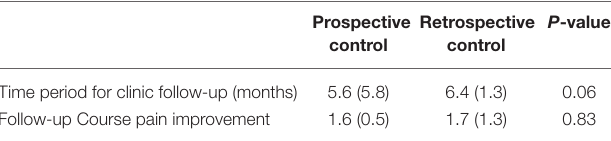
TABLE 2 | Comparison of follow-up times and pain improvement between retrospective and prospective controls.